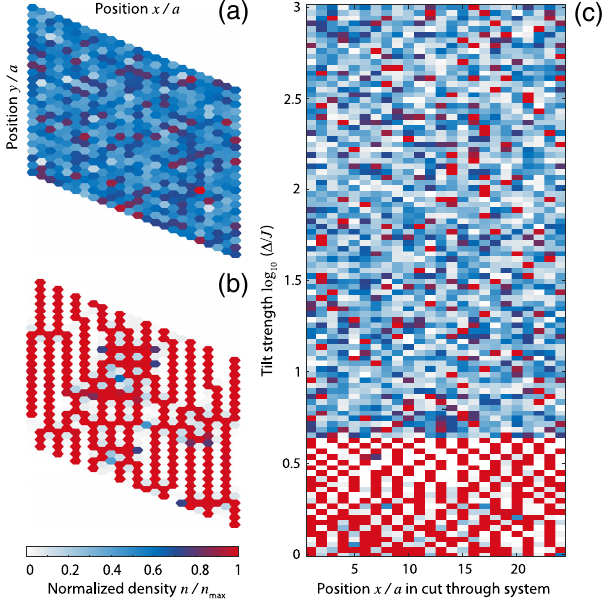
FIG. 8. Monte Carlo simulations. (a),(b) Density distributions n ð x; y Þ of single Monte Carlo samples of the effective model for tilt energy Δ and tunnel energy J with log 10 ð Δ =J Þ ¼ 2 . 0 (a) and log 10 ð Δ =J Þ ¼ 0 . 5 (b). The density is normalized by the maxi- mum density n for each image. (c) Cuts through images as in max (a) and (b) as a function of Δ =J . The density-wave pattern is visible below a critical value of Δ =J ∼ 4 . 4 , and above this critical tilt the density is randomly